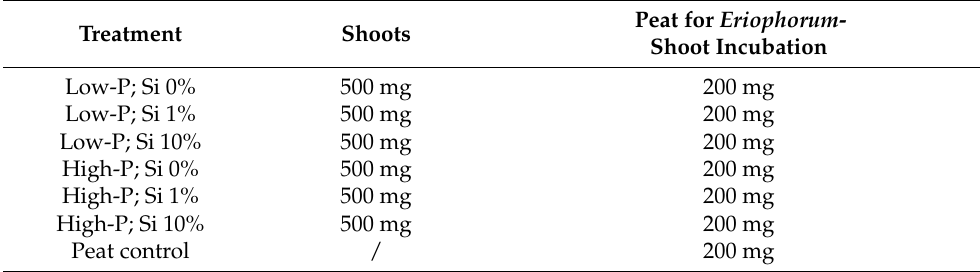
Table A2. Treatment additions in the decomposition